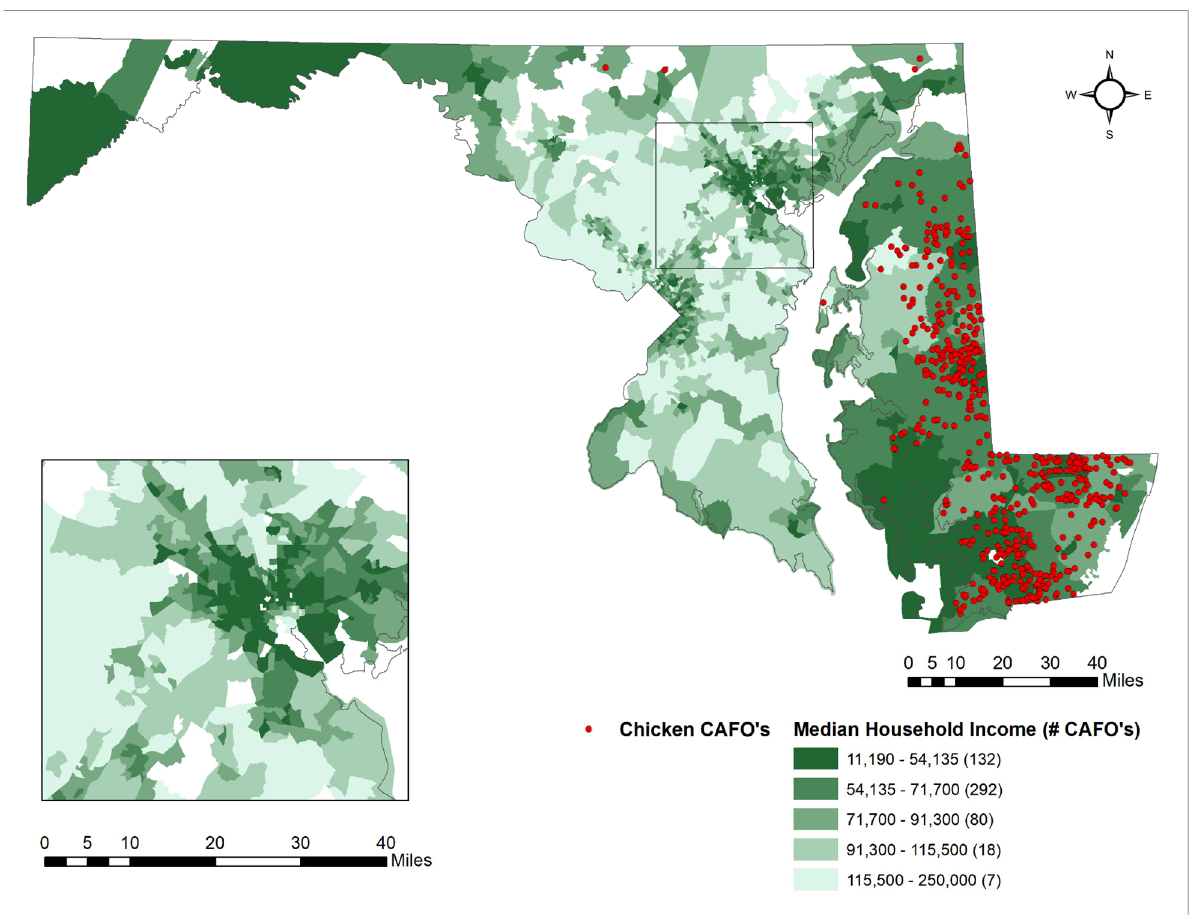
Figure 4. Chicken CAFOs by Quintiles of % Population of Median Household Income. The largest concentrations of people of color tend to be in the Baltimore area which showed a spatial relationship to the presence of CAFO coldspots (Figure 5). On the other hand, there is a comparatively smaller population of people of color on the Eastern Shore where large CAFO hotspots exist (Table 2). However, the percentage of people with low median household incomes tended to be high in both the Baltimore and the Eastern Shore areas. When comparing this to the CAFO and meat processing facility locations in Figure 1, there appears to be a tendency for CAFOs and meat processing facilities to be located in areas with low median household incomes (see Figure